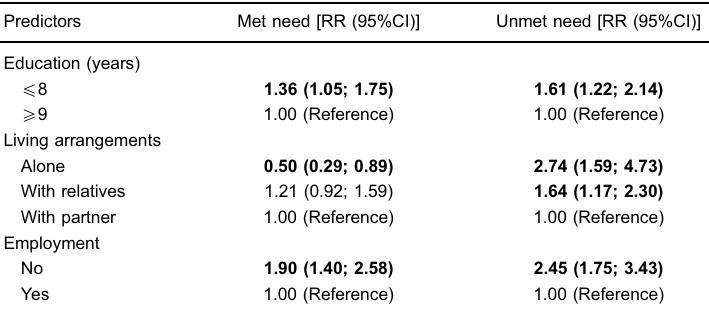
Table 3. Predictors of the met and unmet needs of patients at least four years after their fi rst psychiatric admission according to zero-in fl ated negative binomial (ZINB) regression